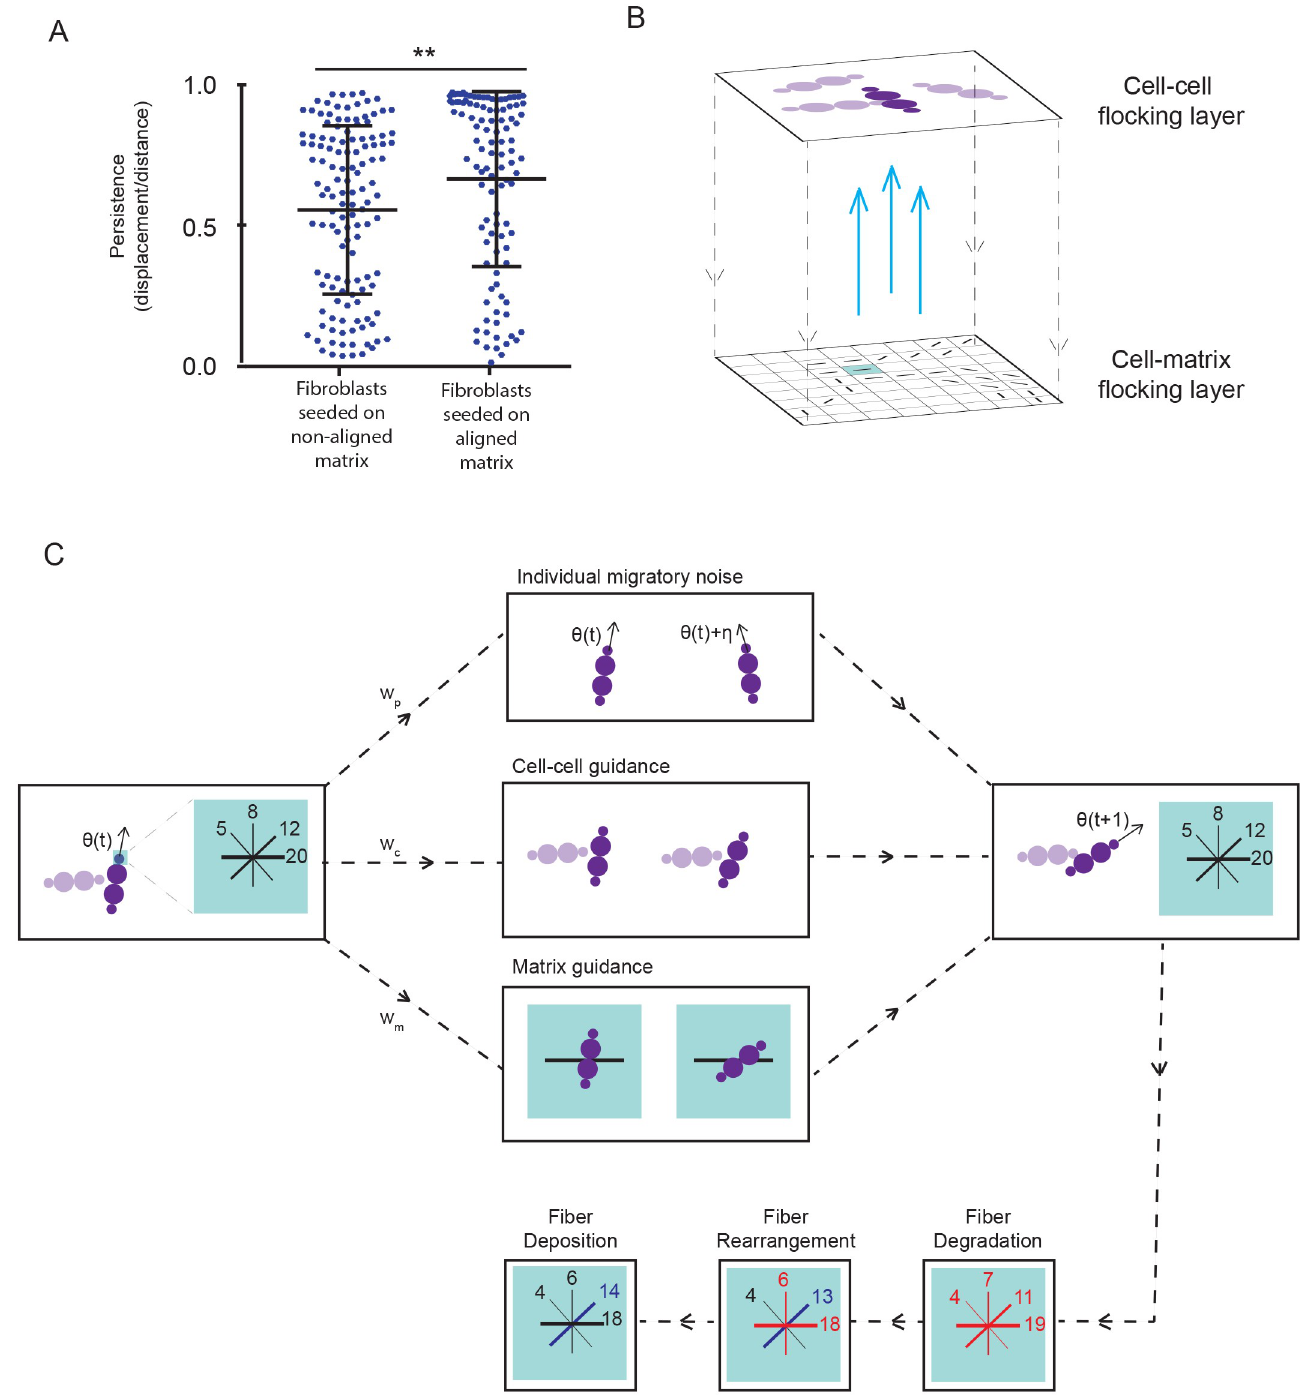
Fig 2. A multi-layered flocking model of cell-cell and cell-matrix interactions. (A) Migratory persistence of aligning or non-aligning fibroblasts seeded on a thick aligned matrix (over 8 hour windows). On an aligned matrix, fibroblasts migrate with higher persistence (p = 0.0064, using a two-tailed t-test). (B) Schematic showing the two-layer set up of the model. (C) Schematic describing the model. Cells flock with other cells they come into contact with and the fibers in the matrix grid point underneath the head of the cell. At every time step, for each cell in turn we compute its change in orientation due to flocking with other cells, its change in orientation due to flocking with the matrix below and its reorganization of the matrix in the grid point below via degradation, rearrangement and deposition of fibers. In this schematic, there are four bins per grid point for fibers to be deposited in.